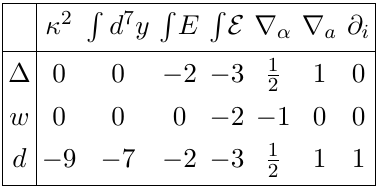
Table 3 . Weyl ((cid:1)) and U(1) R ( w ) weights of various measures and actions. We denote R E = R d 4 x d 4 (cid:18) E and R E = R d 4 x d 2 (cid:18) E